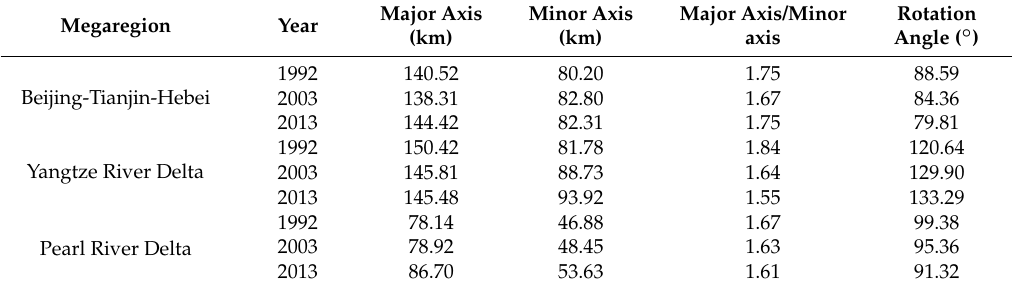
Figure 4. Geographical distribution of urbanization expansion employing the calibrated spatiotemporally continuous lighted areas (DN ≥ 12) in upper row ( a1 – c1 ): 1992 (green), 2003 (yellow) and 2013 (red). Gravity Center trajectories (from 1992 to 2013, middle row: a2 – c2 ) and the related Weighted Standard Deviational Ellipses (bottom row: a3 – c3 ) in megaregion scale combined with gray megaregions as background. Note that circles represent the trajectory of the annual Gravity Centers of nighttime lights and the triangles show Geometric Center in 2013. Table 3. Statistics of the Weighted Standard Deviation Ellipse parameters in the three megaregions of the Beijing-Tianjin-Hebei (BTH), the Yangtze River Delta (YRD) and the Pearl River Delta (PRD) for the years 1992, 2003 and 2013, including major and minor axes, areas, azimuth/rotation